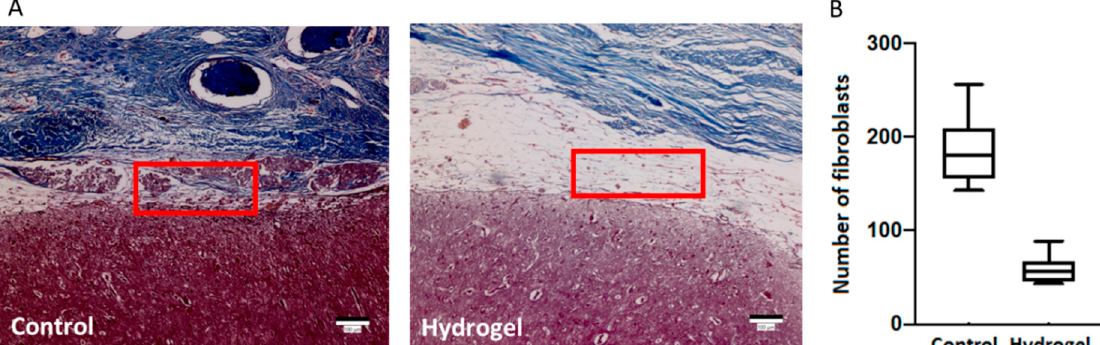
Figure 8. ( A ) The hematoxylin-eosin (H&E) staining image of untreated dural defect (control) and dural defect treated HC13 hydrogel (hydrogel). ( B ) The number of fibroblasts in the formed adhesion tissue between brain and muscle layer of scalp (circled in red) was determined from direct cell count under high power field.